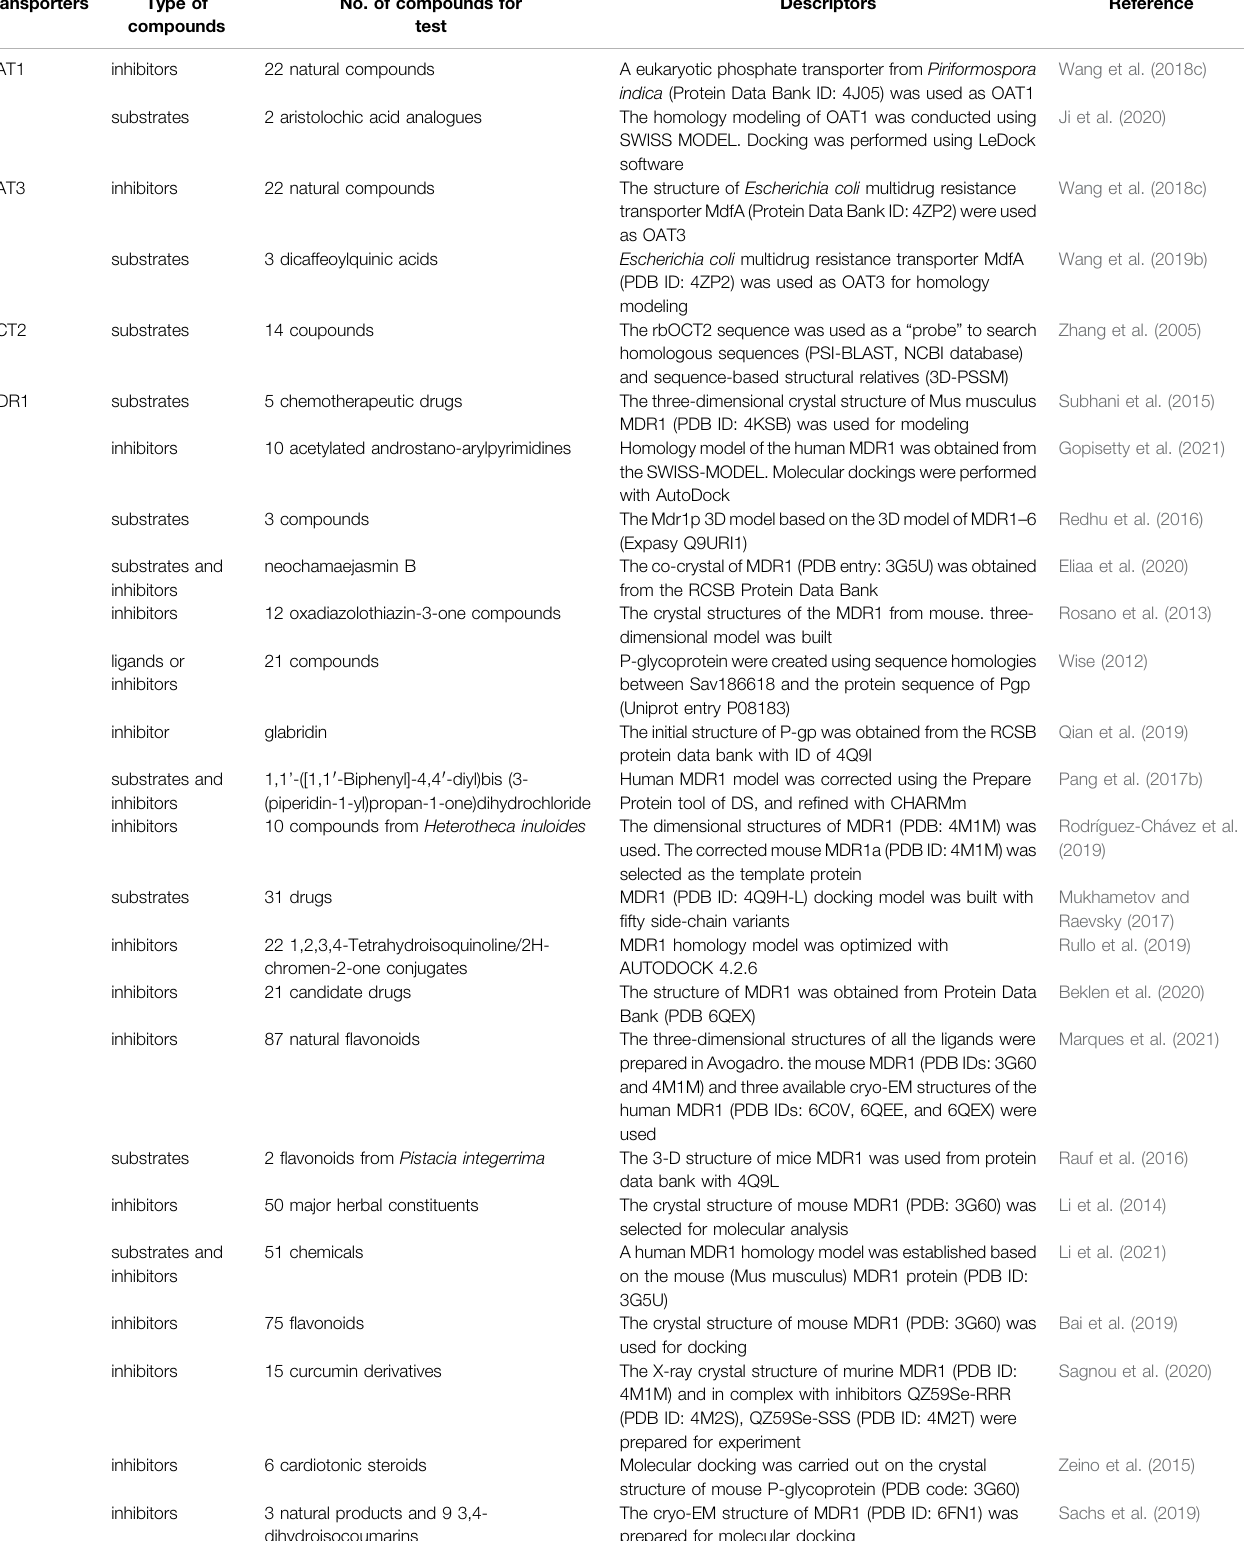
TABLE 6 | Summary of published molecular docking models for assessing the substrates and inhibitors of drug